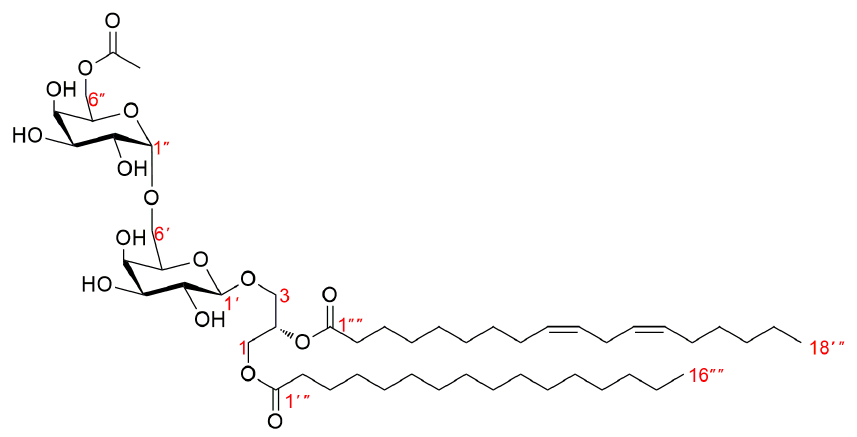
Figure 2. Key 1 H- 1 H COSY and HMBC correlations of compounds 1 and 2.